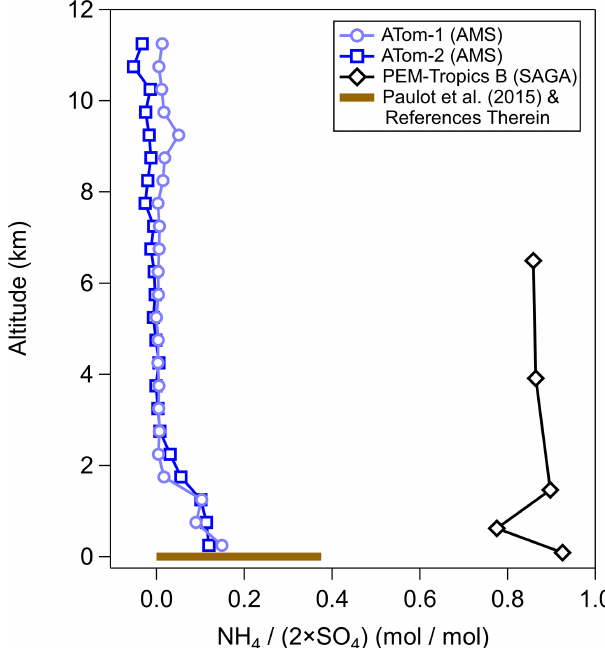
Figure 1. Vertical profile of sulfate-only ion molar balance (moles ( NH 4 )/ moles ( SO 4 ) ) measured during PEM-Tropics by col- lecting aerosol on filters and analyzing it offline with ion chro- matography (Dibb et al., 2002) and during ATom-1 and ATom-2 by AMS (Hodzic et al., 2020). The ammonium balance profile is for observations collected during ATom-1 and ATom-2 between − 20 ◦ S and 20 ◦ N in the Pacific basin, so the observations were in a similar location as the PEM-Tropics samples. Also shown is the ammonium balance from observations summarized in Paulot et al. (2015), and references therein, for the area around the same location as PEM-